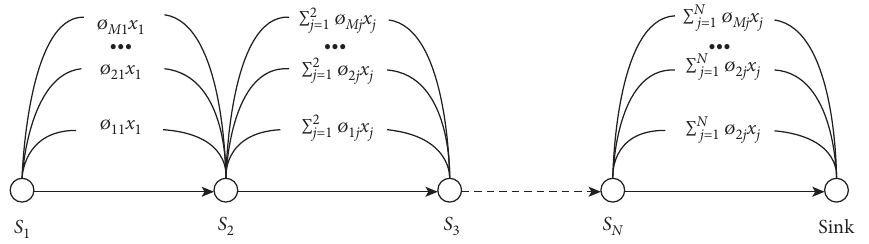
Figure 1: Data gathering process based on Compressed